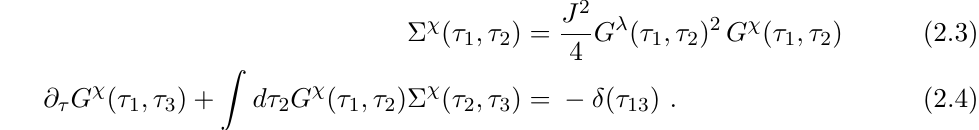
(cid:17) (cid:28) (cid:0) (cid:28) . On the other hand, the two 12 1 2